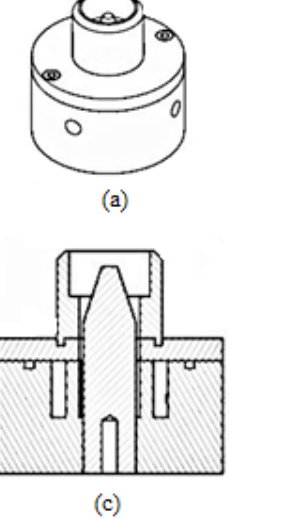
Figure 12. Schematic view of the gliding arc plasma-assisted burner. ( a ) an overall view of the burner. ( b , c ) cross-sections of the burner.